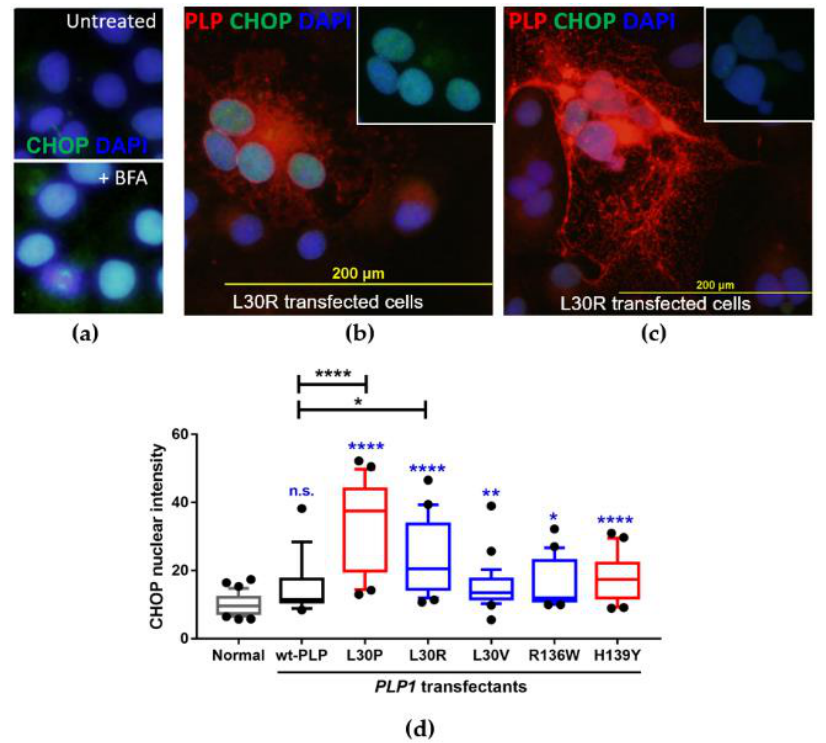
Figure 4. Induction of the unfolded protein response (UPR), as indicated by increased CCAAT/enhancer binding protein homologous protein (CHOP) expression in the nuclei following Brefeldin A (BFA) treatment. ( a ) CHOP staining in untreated (no BFA) cells and Cos-7 cells treated with BFA for 6 h. Nuclei are stained blue with DAPI. In the untreated cells, the level of BFA staining was very low. In the treated cells, the overall level of CHOP expression (green) was higher, and there was a concentration of CHOP in the nuclei. ( b ) Examples of CHOP accumulation in L30R transfected cells in which PLP was been retained in the ER (inset shows just CHOP and DAPI overlay). ( c ) CHOP did not accumulate in L30R transfected cells in which PLP was able to move out into the cell periphery. ( d ) Summary of the CHOP nuclear intensity in transfected Cos-7 cells 24 h after transfection. Bars show the interquartile range and whiskers the 10th–90th percentile of CHOP staining in the nuclei of at least 20 cells per transfection. Asterisks/text in blue above each bar show p -value compared to normal Cos-7 cells. n.s.: not significant, * p < 0.05, ** p < 0.01, and **** p < 0.0001. Table 4. Predicted half maximal inhibitory concentration (IC 50 ) ( µ M) of potential peptides from the region surrounding residue 30 of PLP for binding to the HLA-DR, HLA-A, and HLA-B alleles carried by the patient when residue 30 is an L or a V. Starting Amino